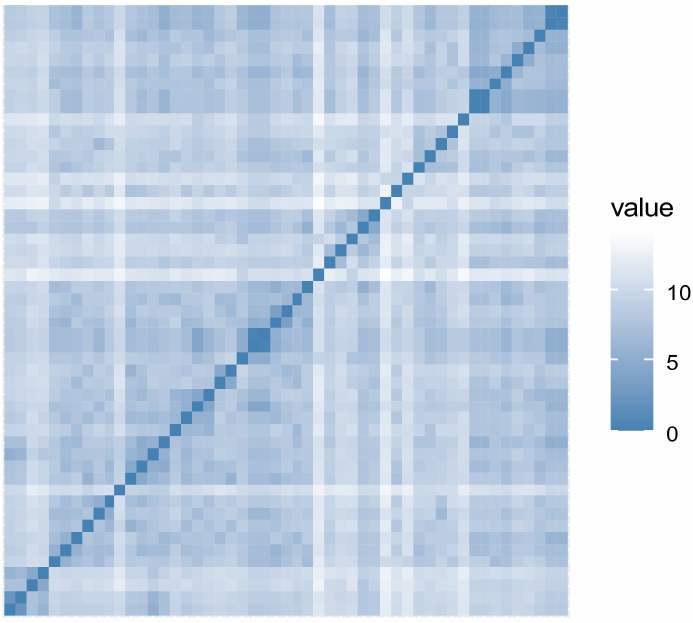
Figure 8. Results of using VAT. The Hopkins statistic [23] is equal to 0.71. This means that dataset is not significantly clusterable. The fuzzy c-mean shows better results (Table 1). All strong instances in each cluster are marked in bold. The same result appears with k-means visualization (Figure 9). Clusters are found to overlap, especially clusters one and